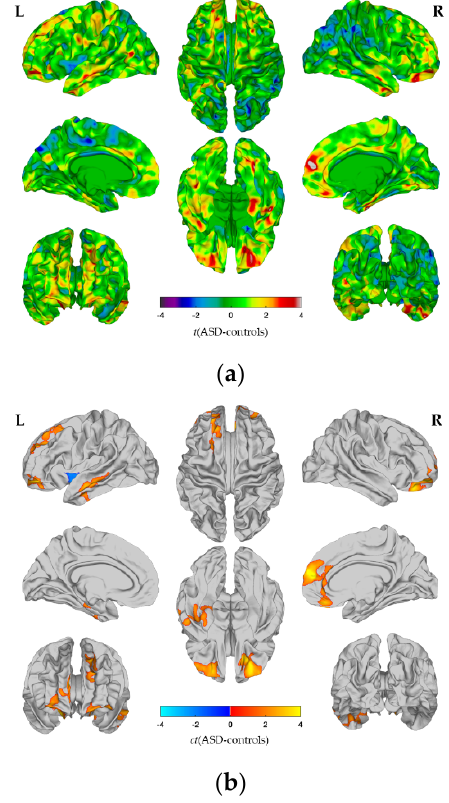
Figure 2. Vertex-wise between-group differences in cortical thickness (CT). Vertex-wise between-group differences in Scheme 1 to T2, i.e., the rate of CT change with respect to the average CT, in individuals with autism spectrum disorder (ASD) compared to neurotypical controls. ( a ) t -test statistic for the contrast ASD minus controls (unthresholded); ( b ) Positive clusters (orange to yellow) indicate significantly less cortical thinning, negative clusters (blue to cyan) indicate significantly stronger cortical thinning in ASD (RFT-based cluster corrected, p < 0.05, two-tailed). Abbreviations: L: left hemisphere, R: right hemisphere.